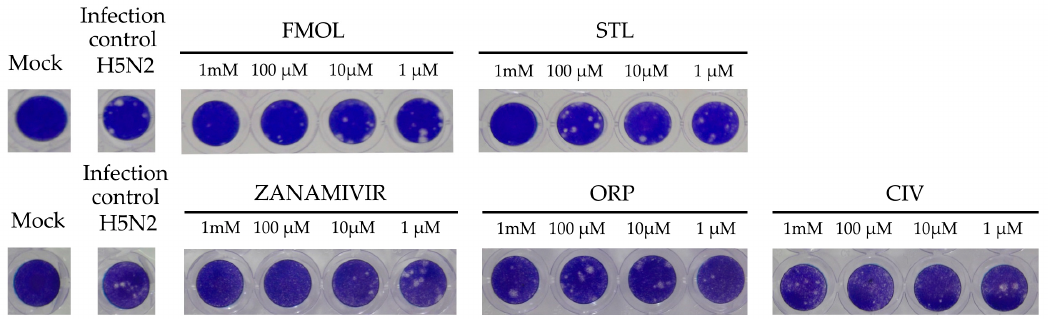
Figure 8. Display of the lytic plaques for inhibition of viral replication. The screening test was carried out for FMOL, STL, CIV, ORP and zanamivir as inhibition control in Madin–Darby canine kidney (MDCK) cells and infecting the avian influenza A A/CHK/MX/1994 H5N2 virus. The number of plaques was counted, and the percentage of activity was calculated by comparing treated versus untreated cells. Of note, the experiment for AAMOL was not carried out.